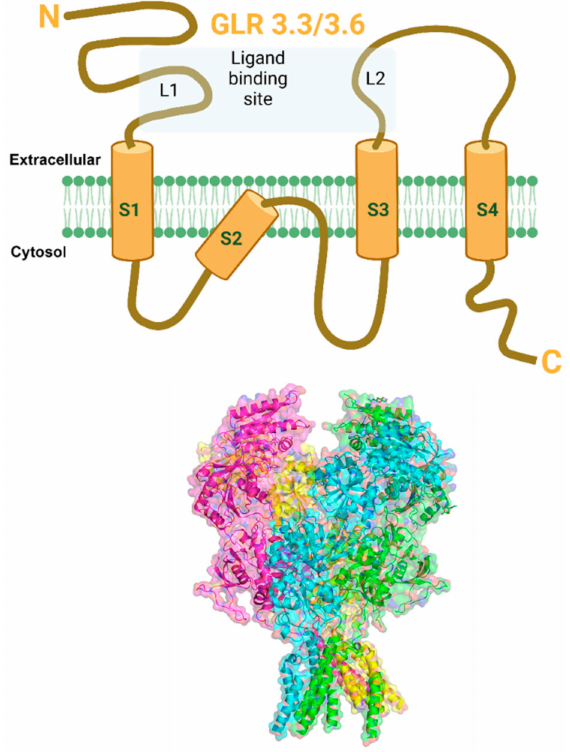
Figure 4. Putative structure of GLR3.3/3.6 channel. (Top) Schematic cartoon representation of GLR3.3/3.6 channel subunit showing extracellular N -terminus, four membrane-spanning regions (S1–S4), 2 extracellular ligand-binding sites (L1, L2), and intracellular C -terminus. (Bottom) The structure of GLR3.3/3.6 has not been solved to date but is likely to show similarities with the animal NMDA receptor family of channels. Therefore, the structure shown in the figure is an approximation based on homology to other channels. The predicted GLR3.3/3.6 secondary 3D structure model showing four subunits in transparent surface view was developed from closest homolog PDB structure 4TLL ( Xenopus laevis GluN1/GluN2B NMDA receptor), using PHYRE